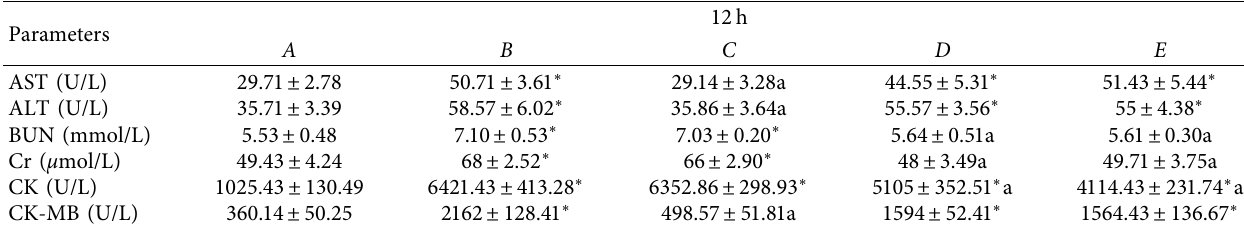
Values are represented as mean ± SEM ( n � 7). Te asterisk in the columns represents a signifcant diference with respect to the blank control group, when p < 0 . 05. Te letter in the columns represents a signifcant diference with respect to the model group, when p < 0 . 05. Table 3: Outcomes of blood biochemical analysis in rabbits 12 hours after the injection with Naja atra venom. Parameters